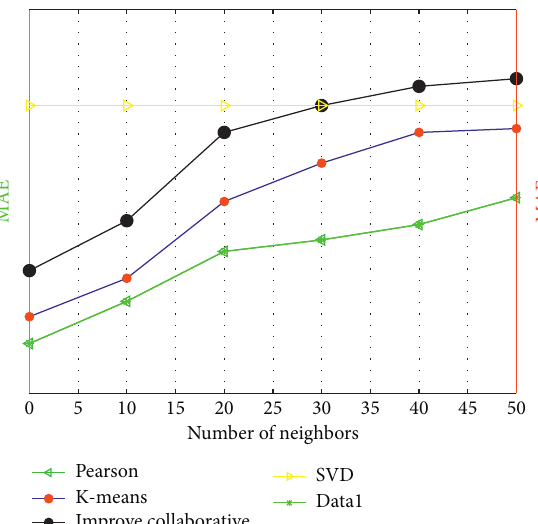
Figure 7: Precision comparison of different collaborative filtering algorithms.